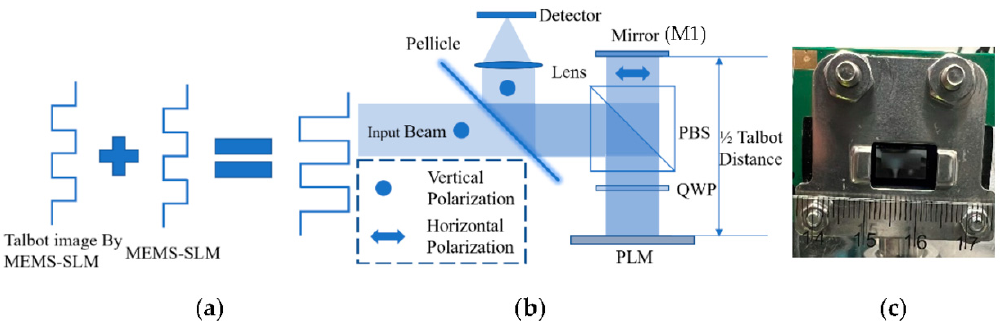
Figure 1. ( a ) Schematic diagrams for pixel matching condition; ( b ) Optical enhancement architecture; ( c ) photograph of the 0.47-inch Texas Instruments Phase Light Modulator. A vertically polarized (VP) and collimated light is deflected by a polarized beam splitter (PBS), followed by passing through a quarter-wave plate (QWP) that converts linear polarization (LP) to right circular polarization (RCP). The SLM reflects and polarization (LCP). The second interaction with QWP changes the polarization of light